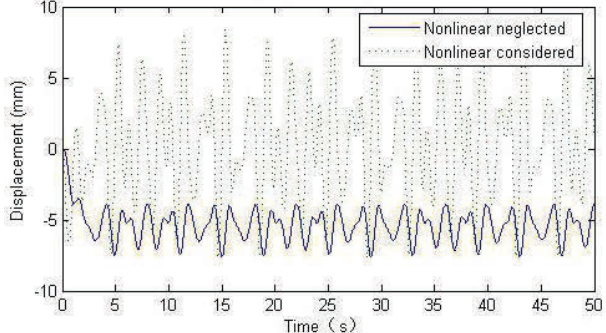
Figure 4. Displacement of mid-span of the bridge under series moving spring-mass system.